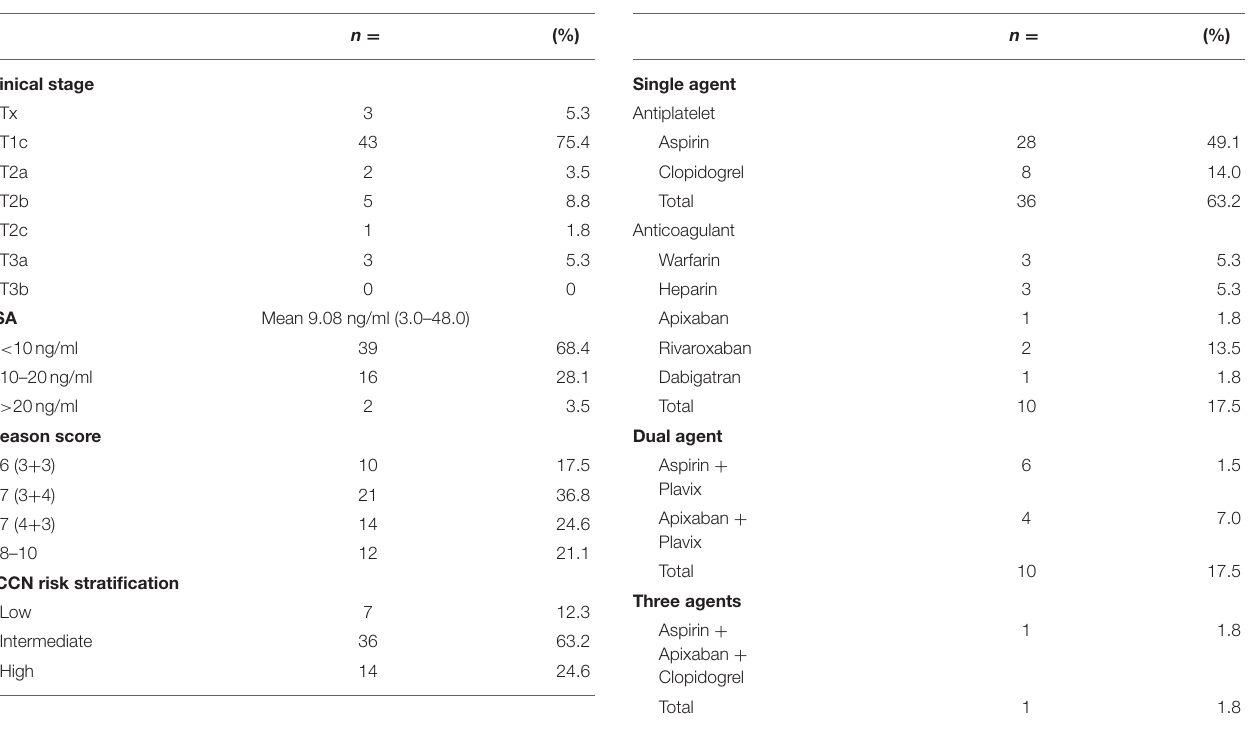
TABLE 1 | Baseline patient characteristics. TABLE 2 | Antiplatelet and anticoagulant medication.